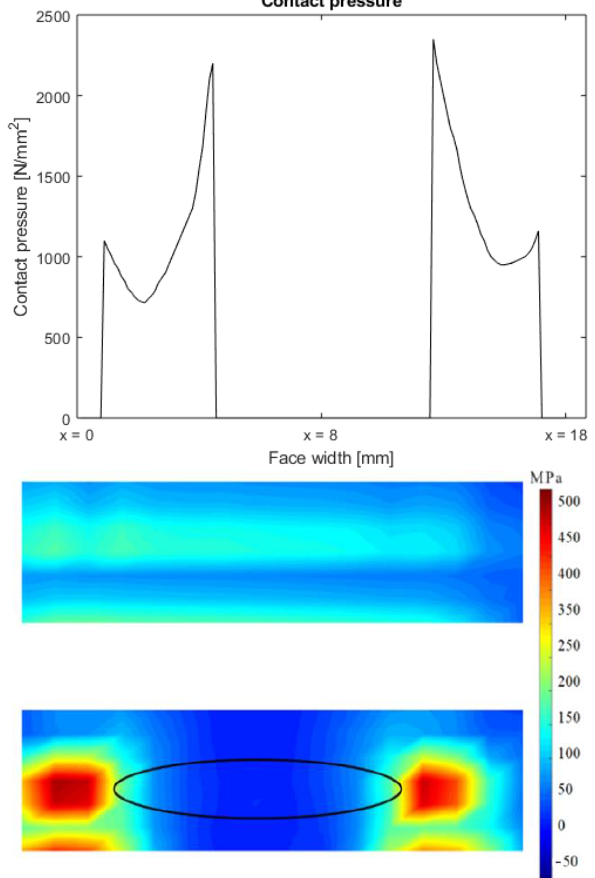
Figure 6. ( Top ): Ten-mm pit contact pressure pattern; ( bottom ): Von Mises component on the face of the tooth. No damage ( bottom ) 10 mm pit ( top ). The ellipse represents the location and size of the pit.